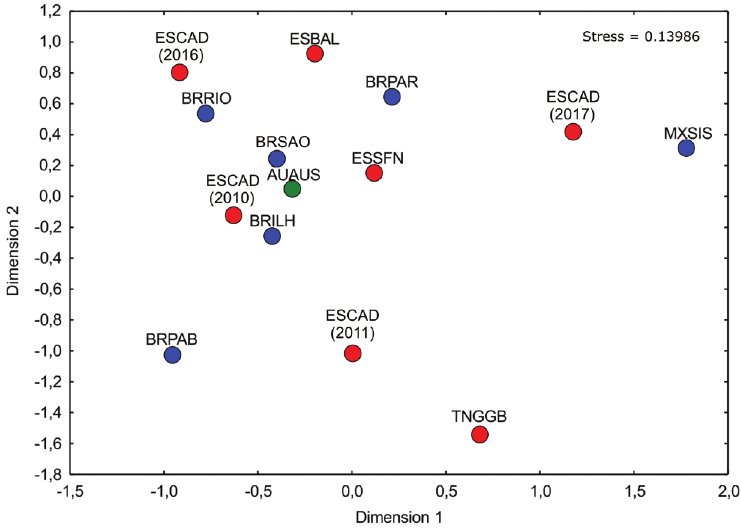
Figure 3. Multidimensional scaling plot (MDS) based on F values for Paracaprella pusilla . For Cadiz ST marina (ESCAD) population, four points are represented, each one corresponding to one of the four years when the species was recorded. Populations are coloured according to the region they belong: Northeast Atlantic + Mediterranean (red); South Pacific (green); and presumed native region (blue). Table 6. Neutrality tests and mismatch distribution analysis for mitochondrial sequences of Paracaprella pusilla for each region. Negative and significant values for Tajima’s D, Fu’s FS and Ramos- Onsis and Rozas’ R tests indicate population expansion; SSD = sum of squared deviations between 2 observed and expected distributions; Rg = Harpending’s raggedness index; * p < 0.05, ** p <